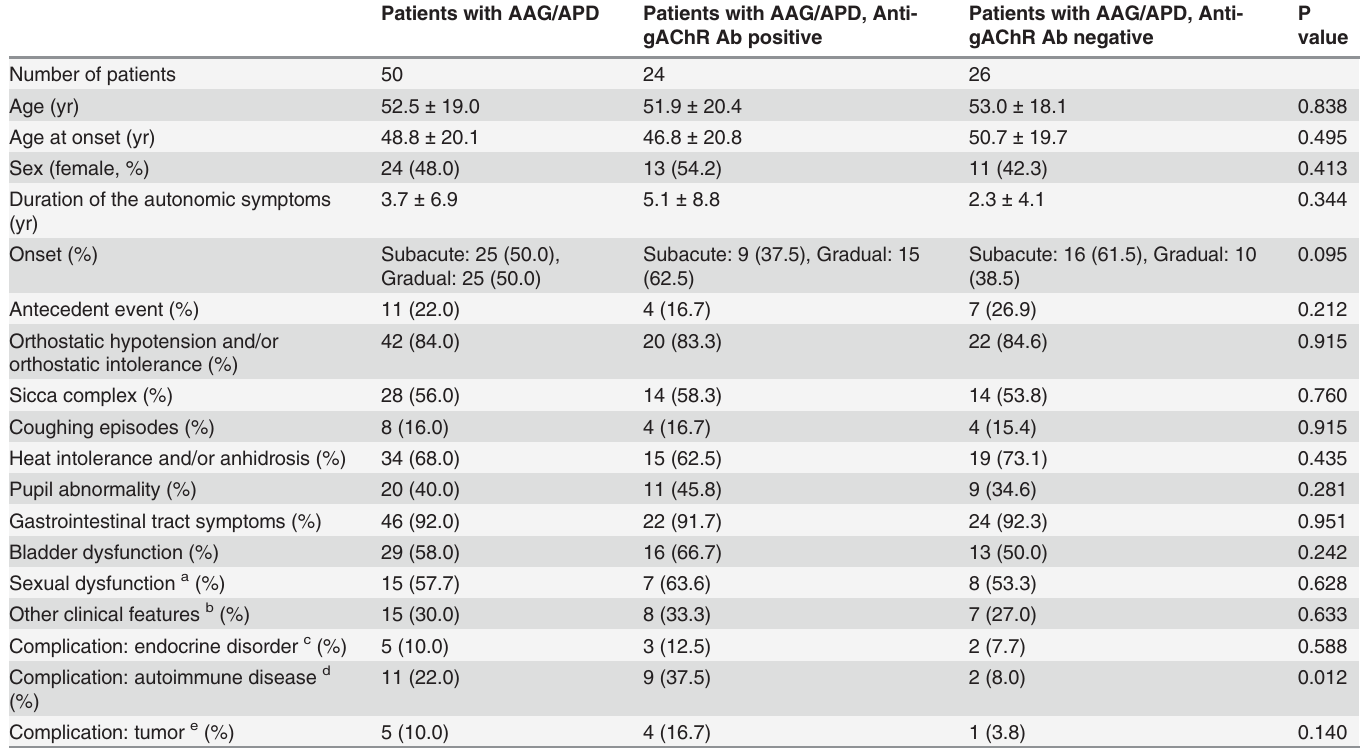
Table 1. Clinical features of patients with